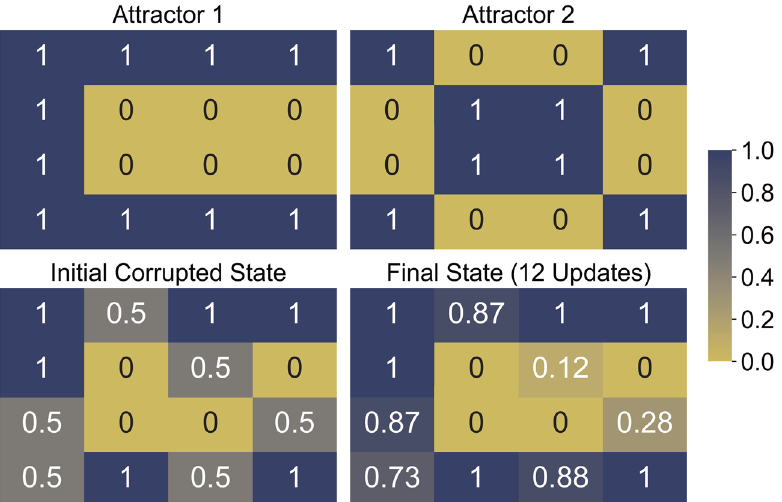
Figure 5. QHAM multiple update demonstration. Updating each corrupted qubit from the Fig. 4c memory twice improves the accuracy of the several of the updated qubits, particularly those which are towards the beginning of the update order.